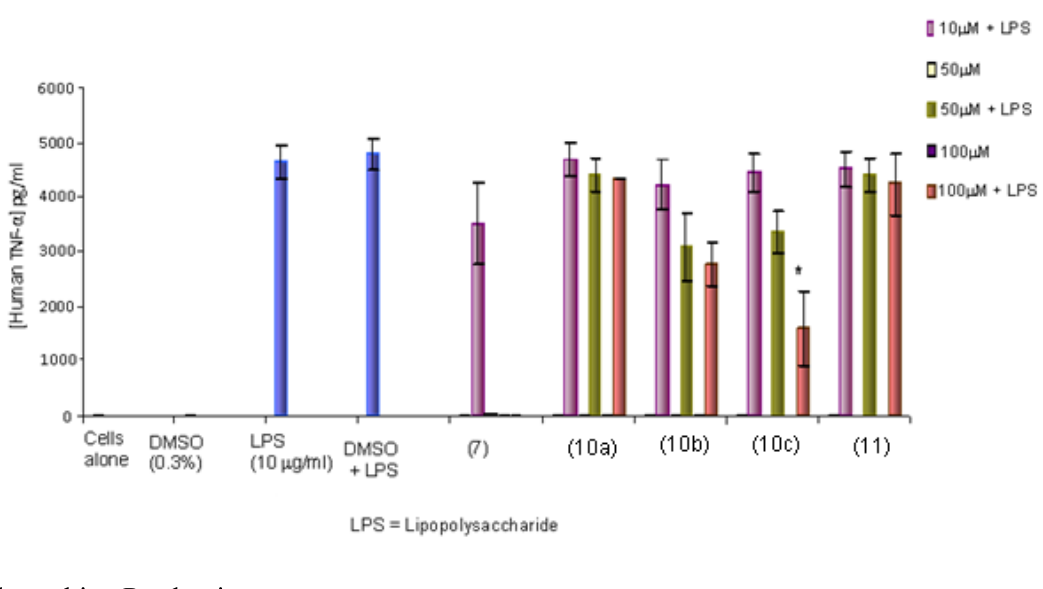
Figure 9. The effects of synthesized curcumin ( 7 ) and thiophene curcuminoids 10a – c , 11 on the production of TNF- α in LPS-induced THP-1 cells using ELISA assay. Results are presented as mean ± SD. * p < 0.05 compared with DMSO + LPS control, * p > 0.05 compared with curcumin control ( 7